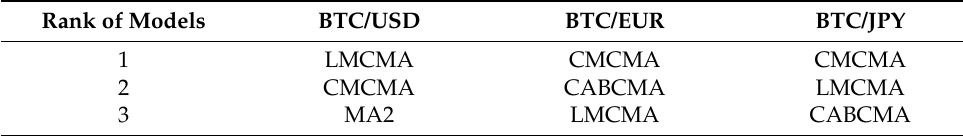
Table 9. Top 3 predictor models ranked using TOPSIS for three datasets.